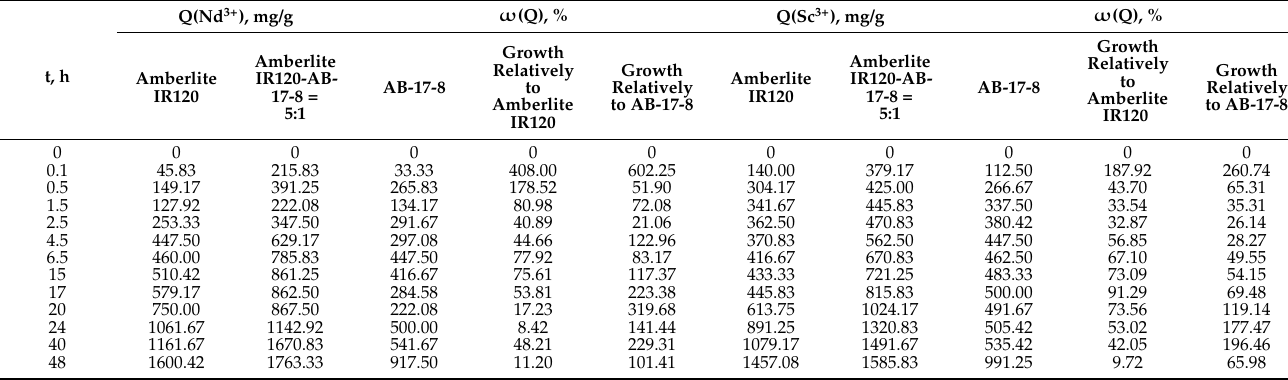
Table 3. Increase of effective dynamic exchange capacity (in relation to Nd 3+ and Sc 3+ ions) in the interpolymer